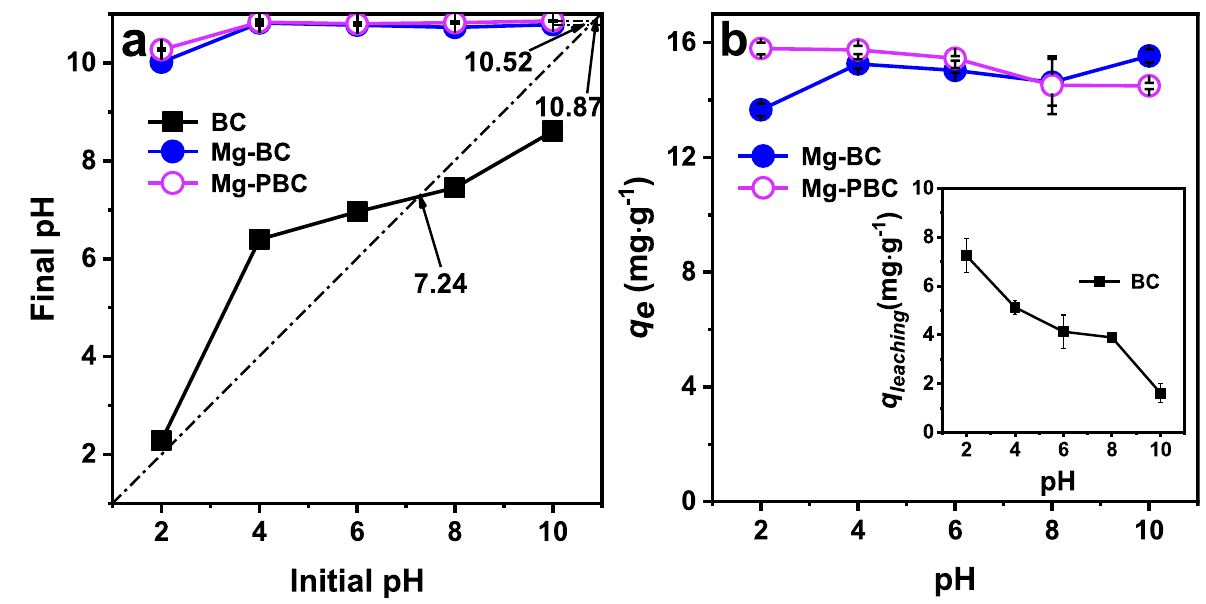
Fig. 3 ( a ) Influence of pH on adsorbents and pH change after adding adsorbent into DI water with different pH values; ( b ) effect of pH on P recovery from livestock